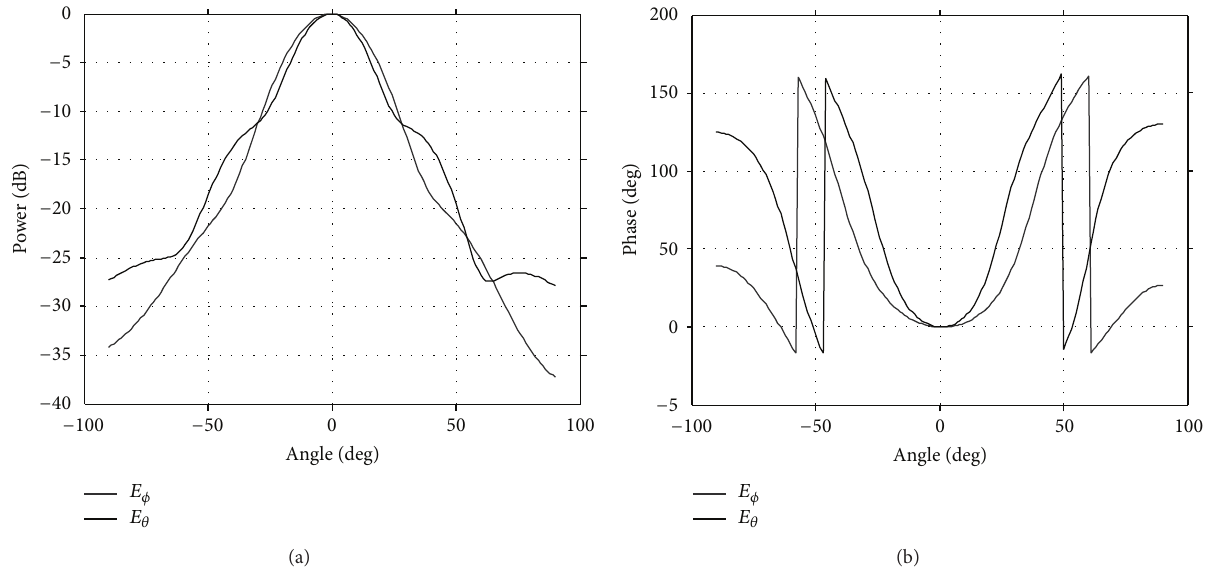
Figure 24: (a) Radiation pattern of conical horn at 𝑟 = 10𝜆 (32 cm). (b) Phase pattern of conical horn at 𝑟 = 10𝜆 (32 cm).